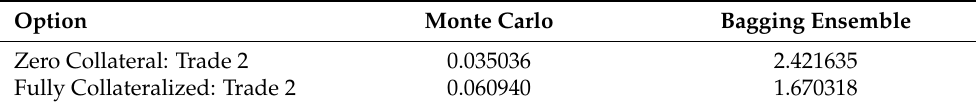
Table 10. Single trade computation time in